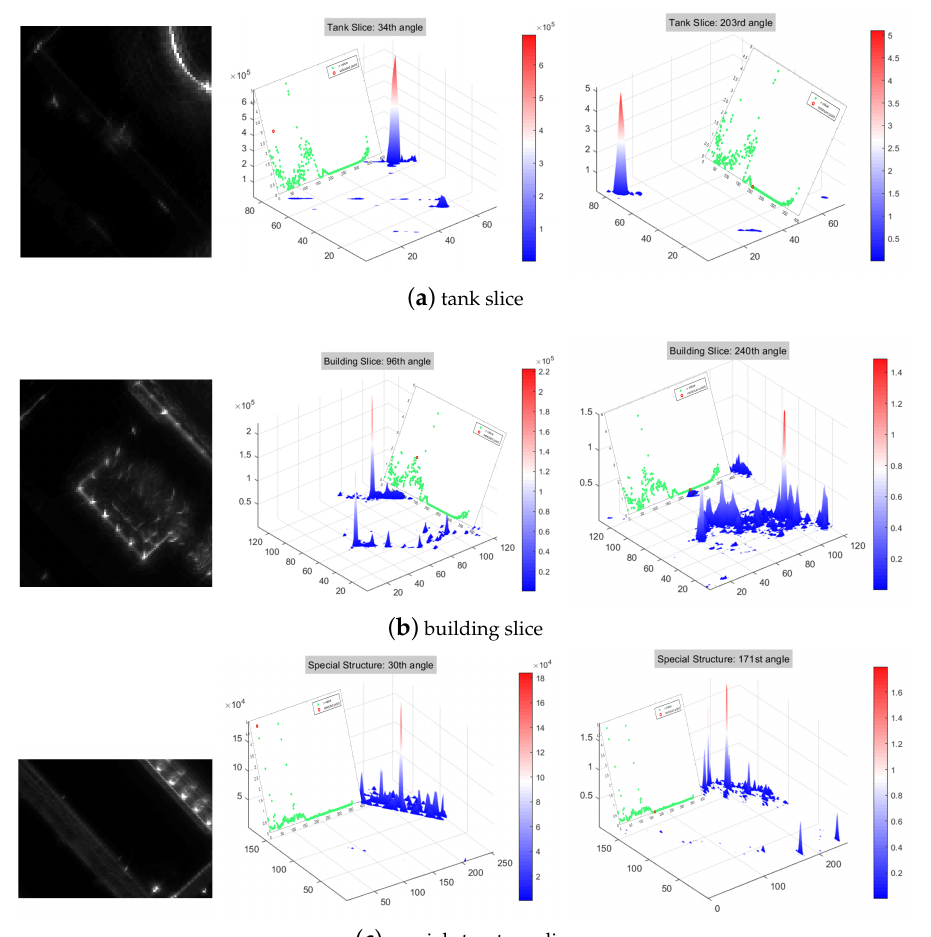
Figure 15. Parameter analysis of tank, building, special structure SAR slice: ( a ) tank slice image, 34th angle σ value and energy distribution, 203rd angle minimum σ value and energy distribution; ( b ) building slice image, 96th angle σ value and energy distribution, 240th angle minimum σ value and energy distribution; ( c ) special struture slice image, 30th angle σ value and energy distribution, 171st angle minimum σ value and energy